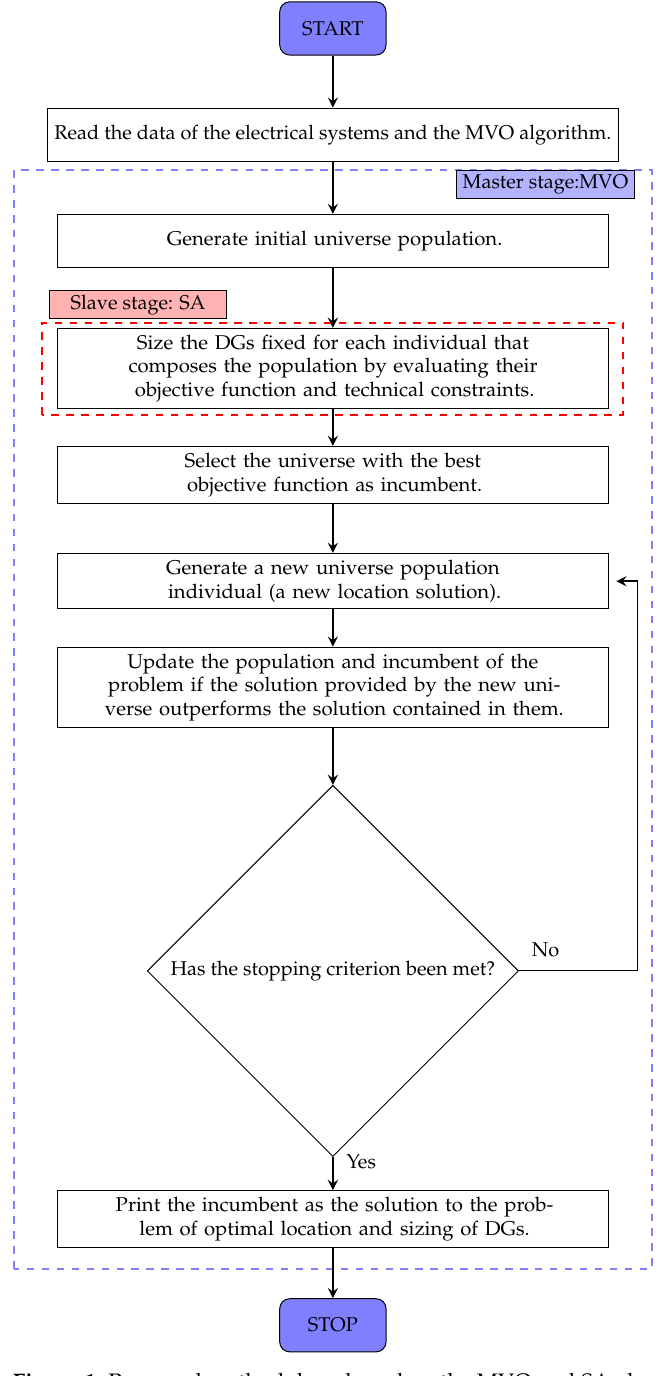
Figure 1. Proposed methodology based on the MVO and SA